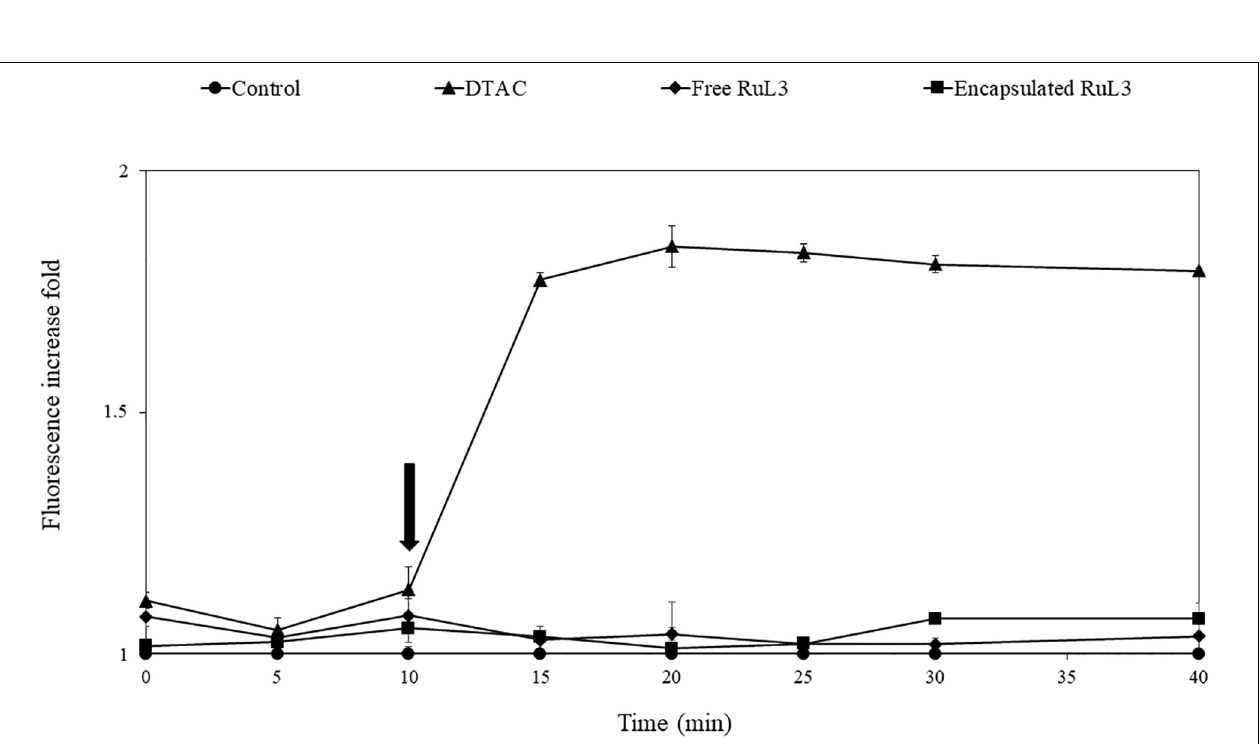
FIGURE 6 | Assessment of Escherichia coli (ATCC 25922GFP) cytoplasmic membrane permeability when exposed to dodecyltrimethylammonium chloride (DTAC), free RuL3, or encapsulated RuL3 at the minimal inhibitory concentration. The black arrow indicates the time at which (DTAC) free RuL3 or encapsulated RuL3 was added. Fluorescence of the green fluorescent protein was measured spectroscopically at 485- to 510-nm excitation and emission wavelengths. Data are presented as means ( ± SD) of three independent repeats in triplicate. The control represents cells treated with HEPES buffer.